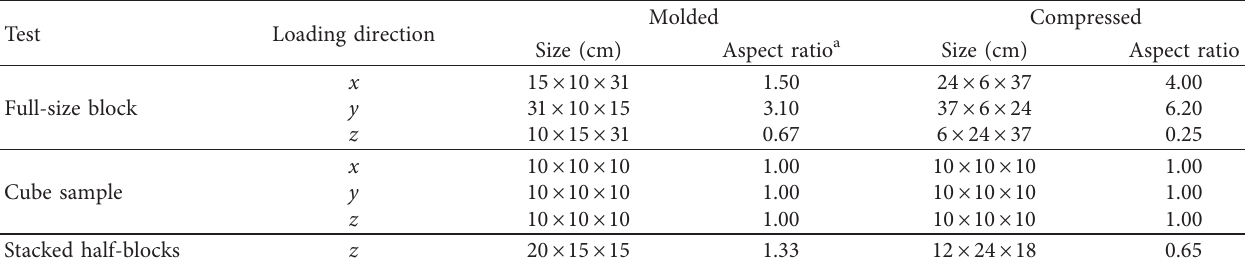
Table 3: Geometric dimension of samples.